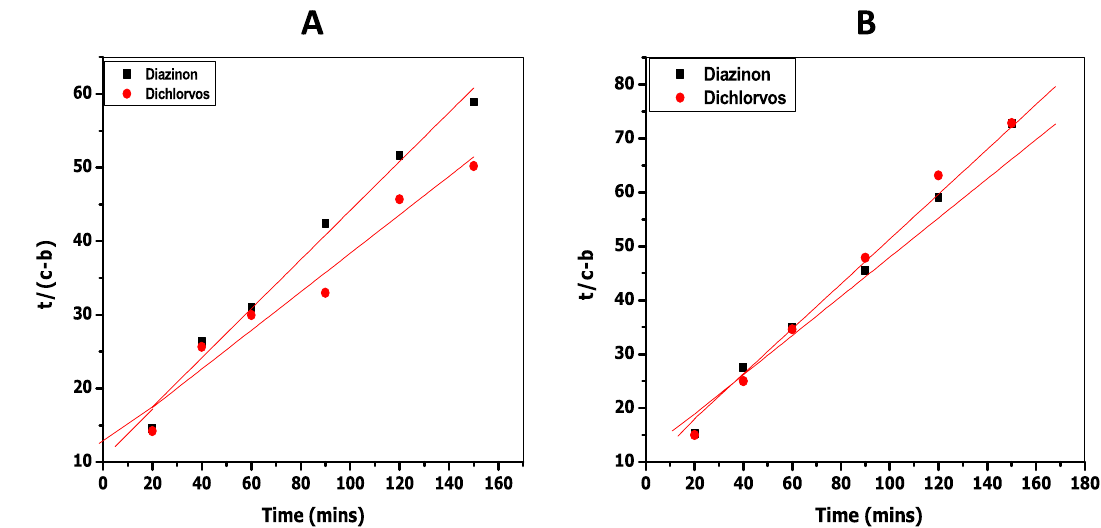
Figure 3. Second-order kinetic plots for ( A ) the adsorption of diazinon and dichlorvos on CDA surface and for ( B ) the adsorption of diazinon and dichlorvos on starch surface at pH 7.0 and 27 °C.